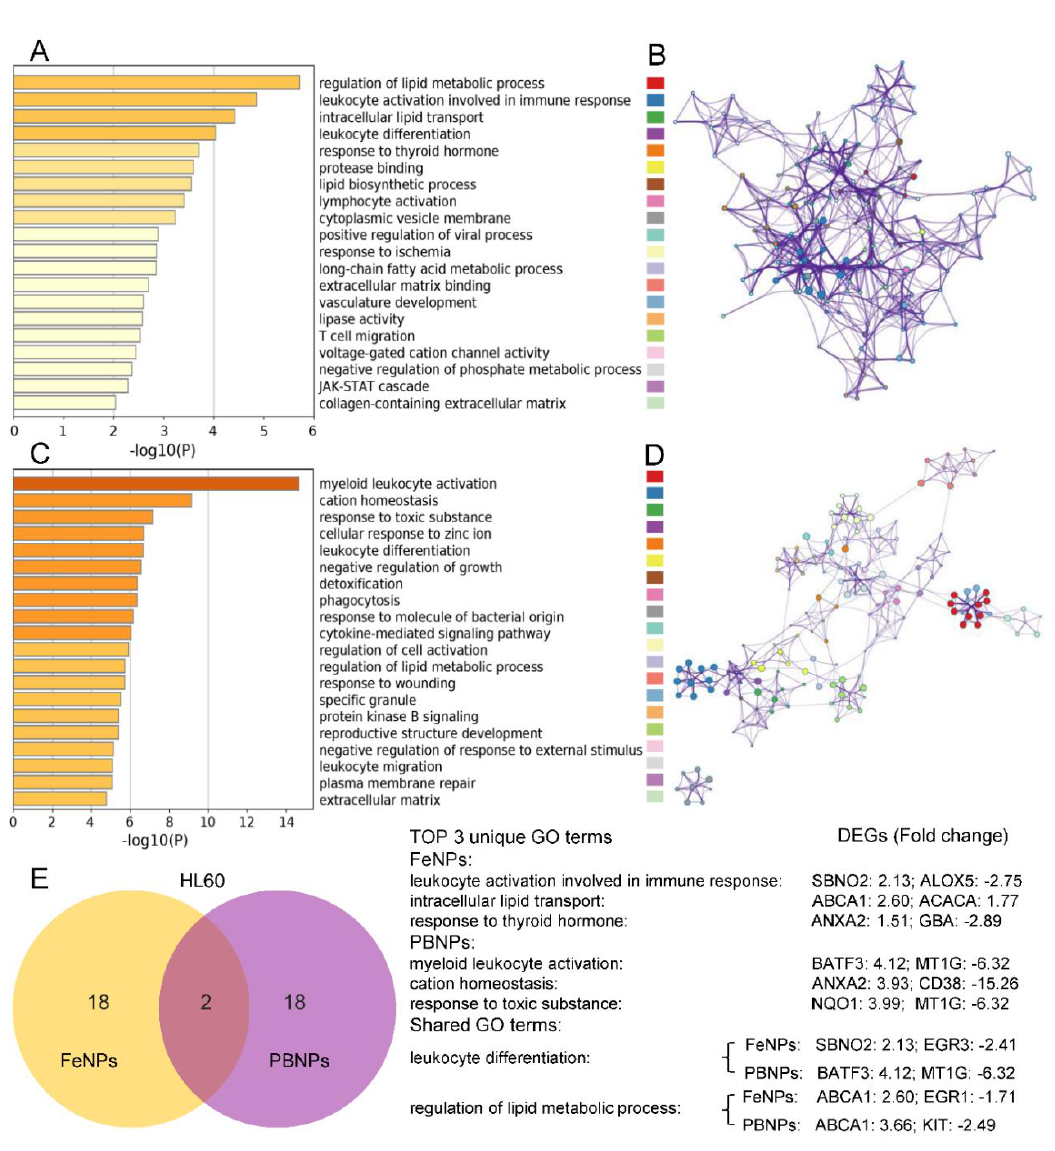
Figure 4. Top 20 Gene Ontology (GO) terms of the HL60 cells treated with two kinds of iron nanoparticles: ( A , B ) heatmap ( A ) and enrichment network ( B ) colored by the same cluster of GO terms in the FeNP-treated HL60 cells, and ( C , D ) heatmap ( C ) and enrichment network ( D ) colored by the same cluster of GO terms in the PBNP-treated HL60 cells. The colored labels followed the order of top 20 GO terms. ( E ) The Venn analysis of top 20 GO terms in the HL60 cells treated with PBNPs and FeNPs. The detailed information of all GO terms is shown in File S2 (Supplementary Materials).